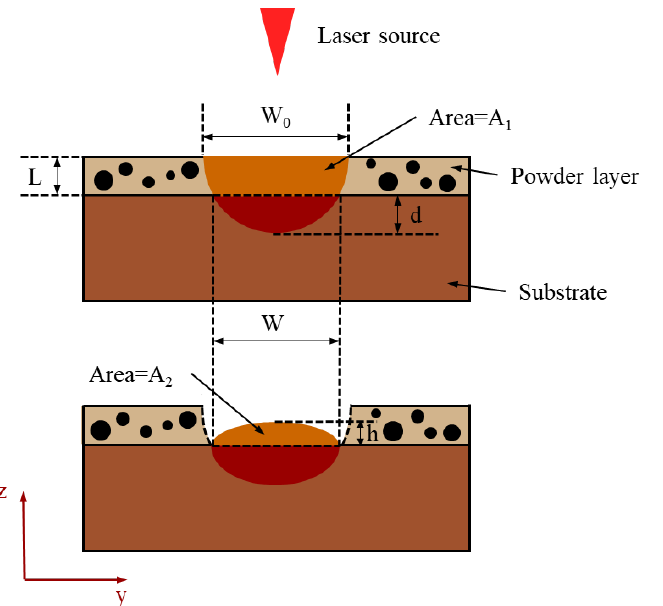
Figure 1. Illustration of the molten pool in melting process (top) and after solidification (bottom). 𝑊 0 represents the width of powder consumed band. 𝑊 represents the molten pool width after solidification. ℎ denotes the cap height (molten pool height after solidification). 𝐿 represents the layer thickness. 𝑑 denotes the re-melted depth.